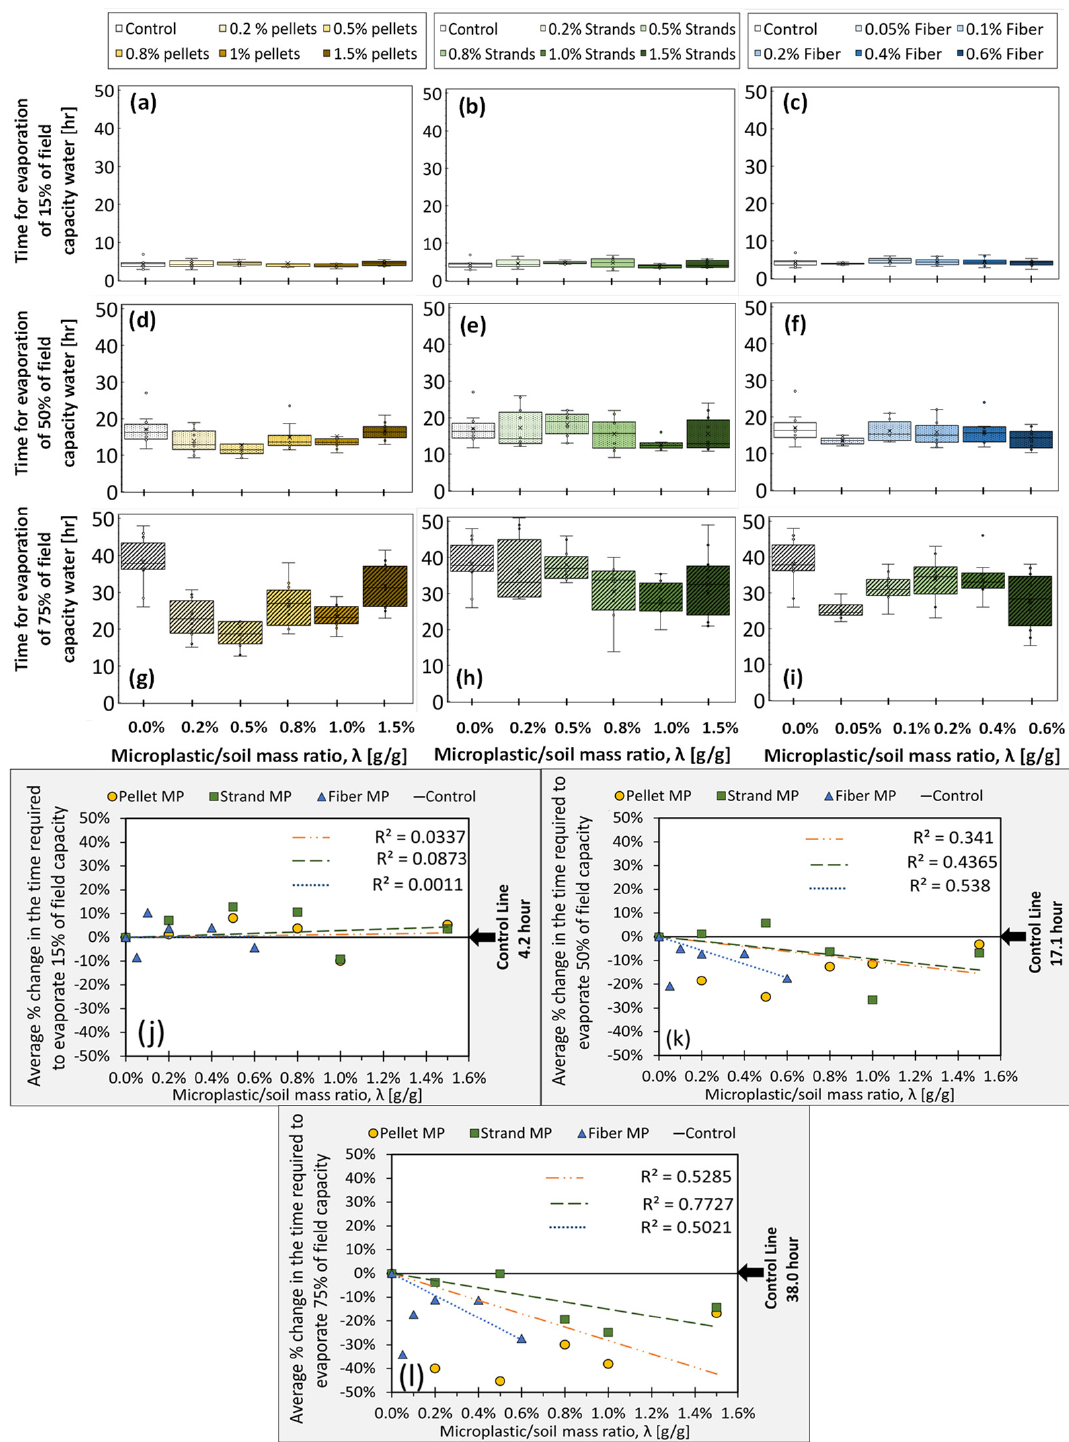
Figure 4. ( a – i ) depict the time required to evaporate 15%, 50%, and 75% of field capacity as a function of λ (g/g), for samples contaminated by pellets, strands, and fibers, respectively. Each boxplot displays the median (middle line), mean (cross), first and third quartiles (lower and upper box lid), and collected data with dots. ( j – l ) show through-the-origin linear regressions of the average values (N = 10 samples).